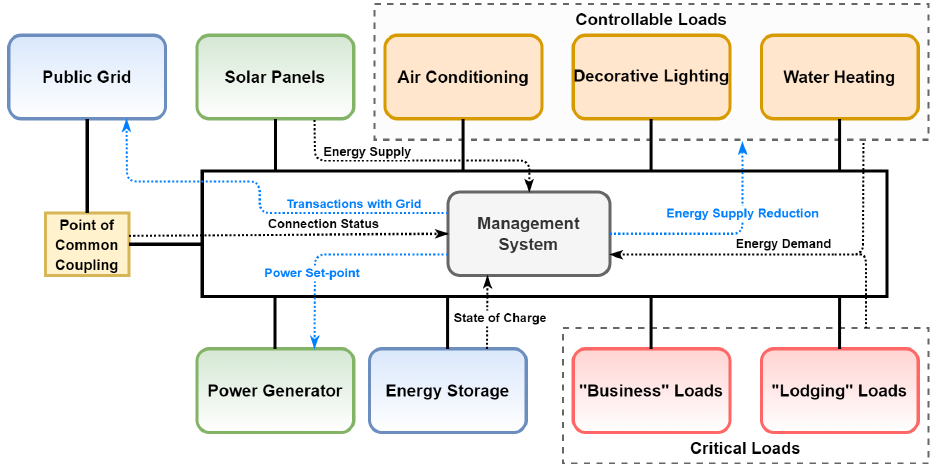
Figure 4. Considered microgrid configuration for a large commercial facility.